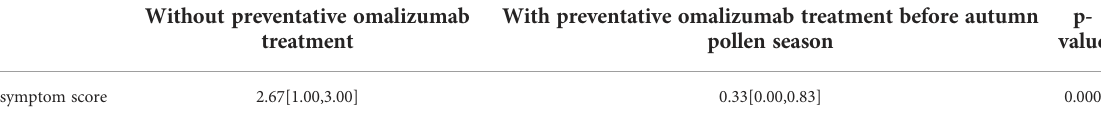
TABLE 2 Preventative omalizumab treatment could improve clinical symptoms of SARC patients signi fi cantly.